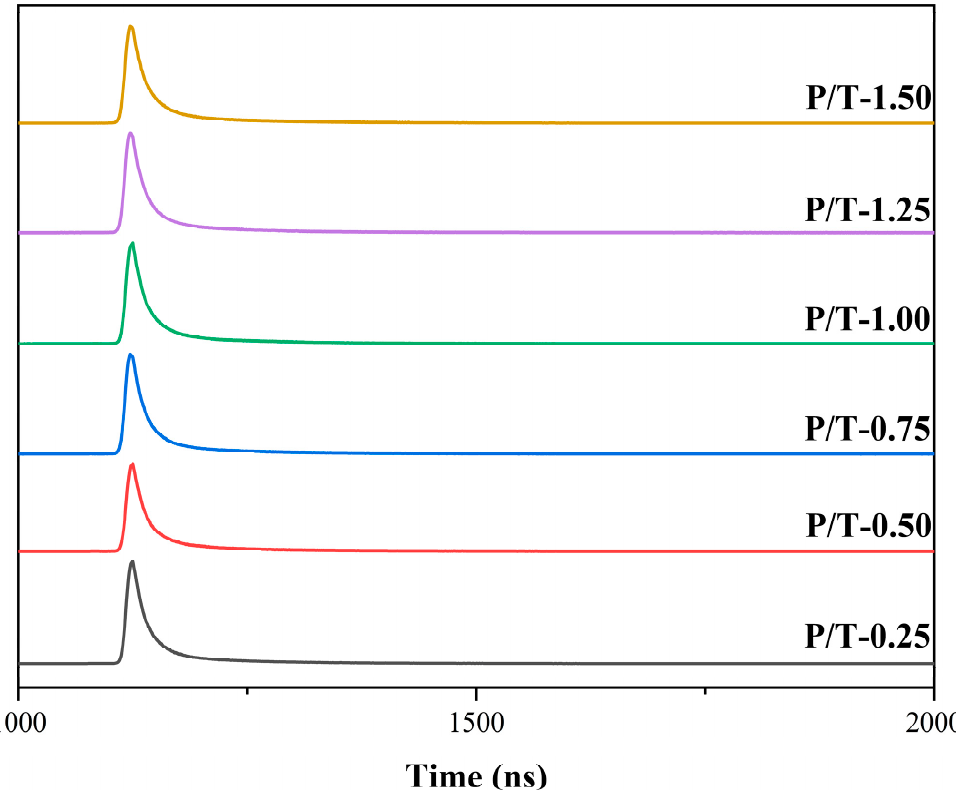
Figure 8. ( a ) The storage modulus ( 𝐸 tan δ curves of different initiator mass fractions samples.